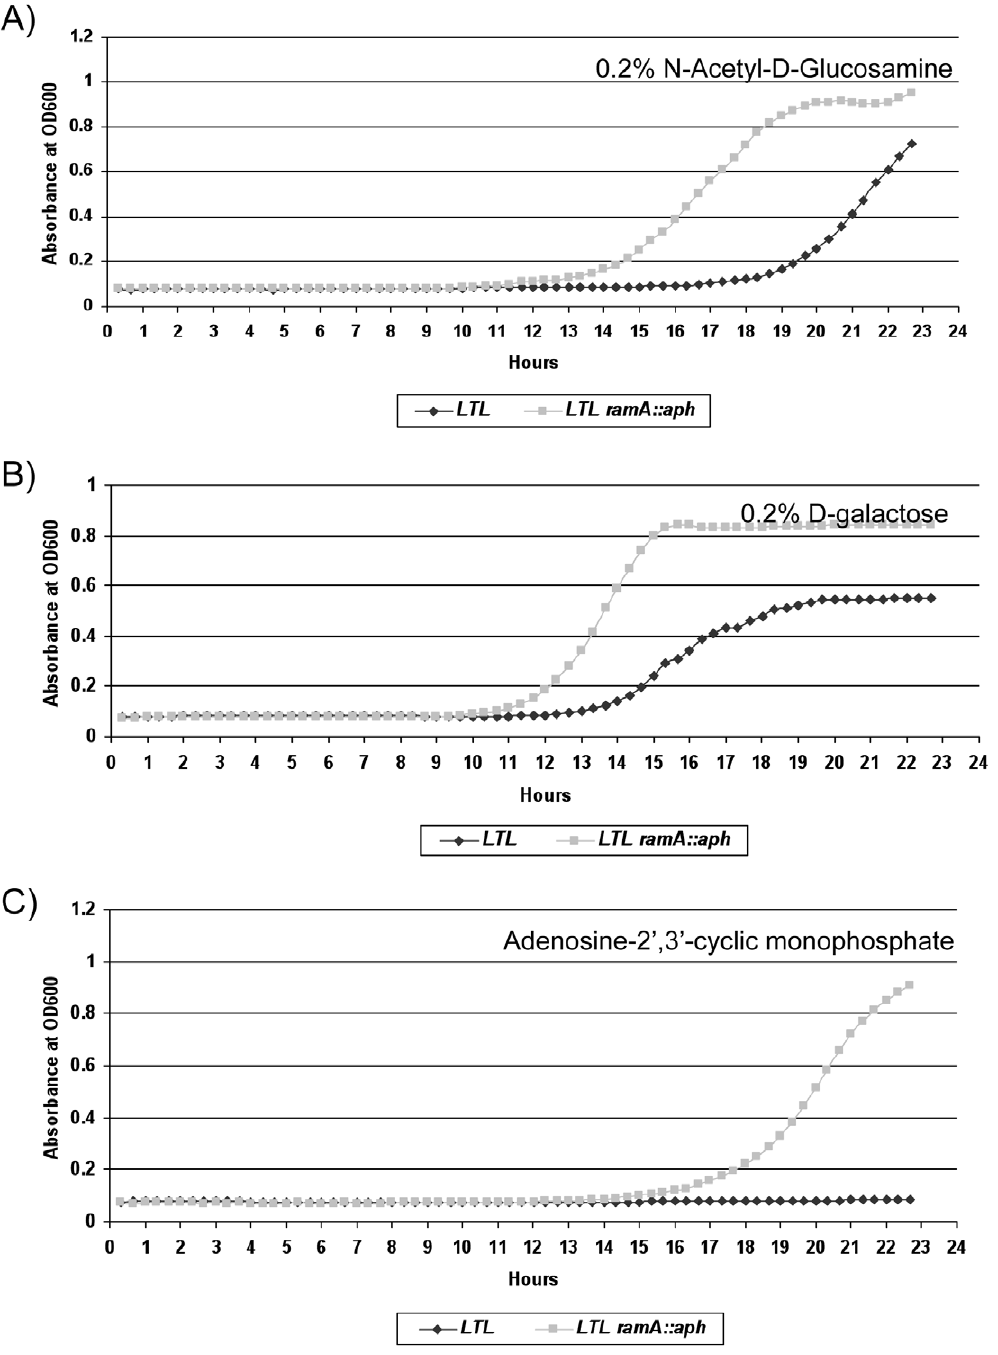
Figure 2. Growth kinetics of S . Typhimurium LTL and its ramA mutant grown in M9 minimal medium containing1 6 M9 salts, 2 mM MgSO 4 , and 0.1 mM CaCl 2 with 0.2% N-Acetyl-D-Glucosamine, 0.2% D-galactose, and Adenosine-2 9 ,3 9 -cyclic monophosphate, as carbon source or phosphate source, respectively. Growth curves were performed with a Bioscreen C Microbiology Reader from Labsystems. Cell growth was monitored at 37 u C with shaking. Absorbance at OD 600 nm (A 600 ) was measured and recorded every 20 min for 24 hrs.